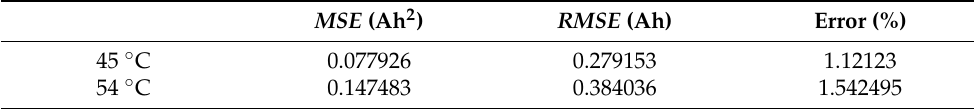
Table 4. The statistical results of the capacity decay model.